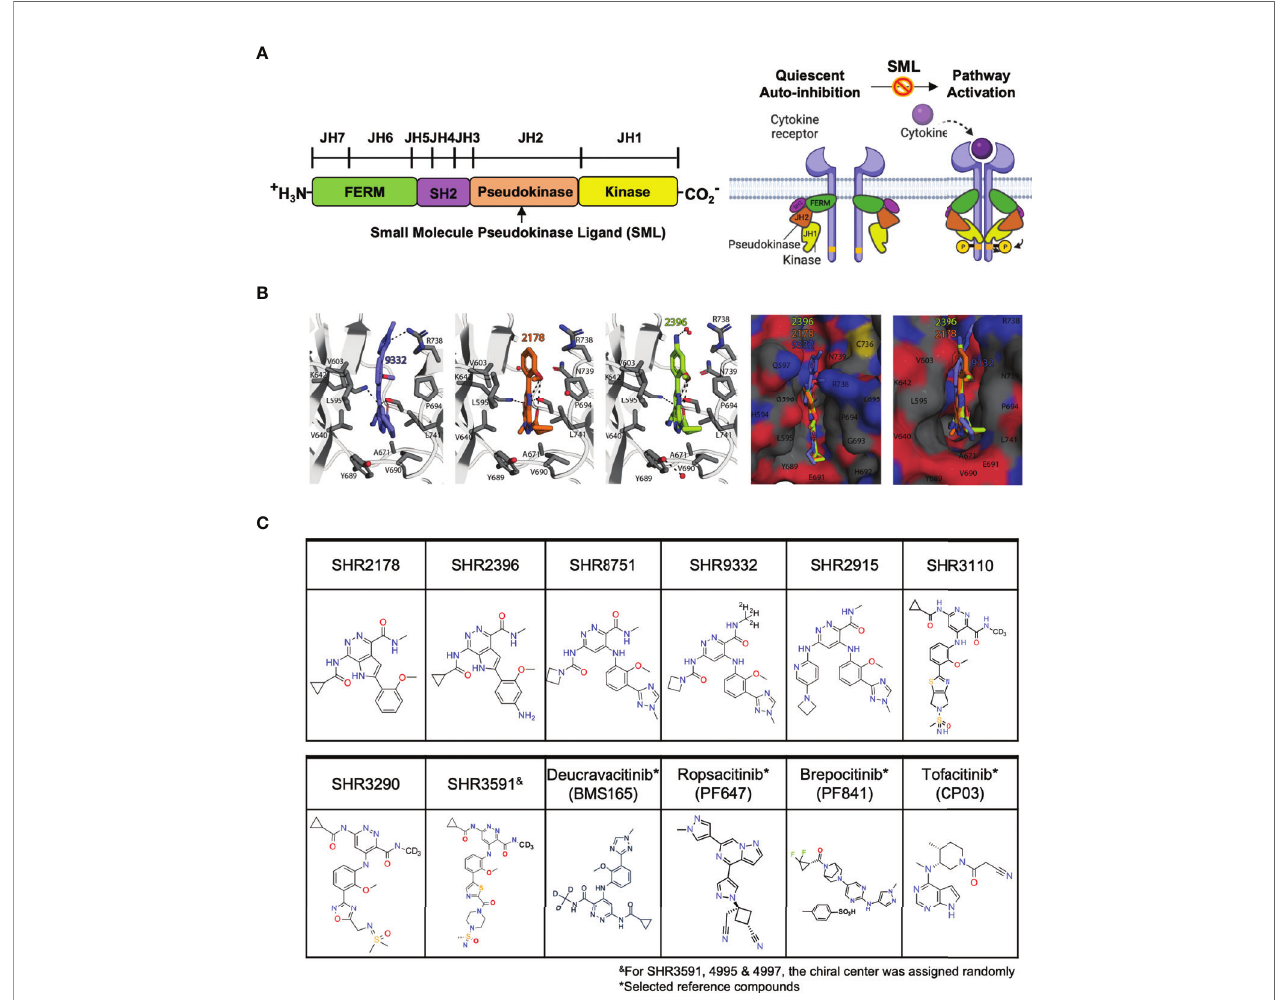
FIGURE 1 | Small molecule ligands bind to the TYK2 JH2 pseudokinase domain. (A) Domain structural illustration of TYK2 and schematic model of cytokine- mediated receptor/TYK2 activation: TYK2 protein contains 4 components: the kinase domain (JH1), the pseudokinase domain (JH2), the FERM (Four-point-one protein, Ezrin, Radixin, Moesin) domain, and the Src homology (SH2) domain; In the quiescent state, TYK2 kinase domain (JH1) activity is autoinhibited by its pseudokinase JH2 domain through intermolecular regulation. Upon cytokine (e.g., IL12, IL23, IFN a ) stimulation, TYK2/STAT pathway is initiated by extracellular binding of cytokines with their cognate receptors, which results in apposition of receptor-associated TYK2 and triggering their enzymatic activity. Activated TYK2 further mediates phosphorylation of STATs on their tyrosine residues, leading to the cascade of down-stream cytokine signaling, including STAT dimerization, nuclear translocation, DNA binding and target gene induction. Small molecule TYK2 JH2 ligands block TYK2-associated cytokine signaling by binding to the TYK2 pseudokinase domain and allosterically inhibiting its kinase activities. This prevents TYK2 from phosphorylating STATs and other substrates, so that cytokine-induced intracellular signals cannot be transduced; (B) Model of the TYK2 pseudokinase domain bound to TYK2 ligands, SHR2396, 2178 and 9332. TYK2 pseudokinase domain residues corresponding to those of protein kinases normally involved in catalytic machinery are shown in stick; (C) Chemical structure of small molecule TYK2 JH2 ligands and JAK kinase inhibitors described in this study [SHR2178, 2396, 8751, 9332, 2915, 3290, 3110, 3591, Deucravacitinib (BMS986165, TYK2 pseudokinase ligand), Ropsacitinib (PF647, TYK2-IN-8, TYK2 kinase inhibitor), Brepocitinib (PF841, TYK2/JAK1 inhibitor) and Tofacitinib (JAK1/JAK3